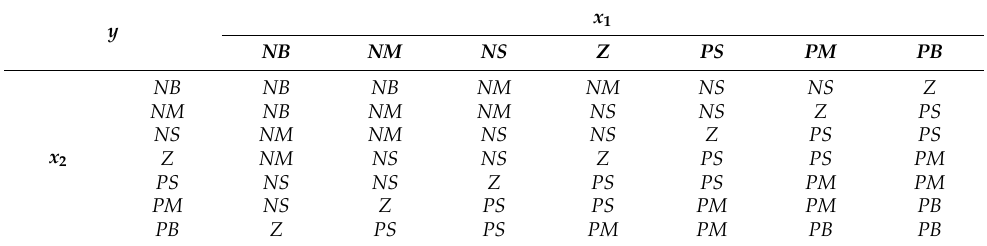
Table 1. Rule base for the FLC.